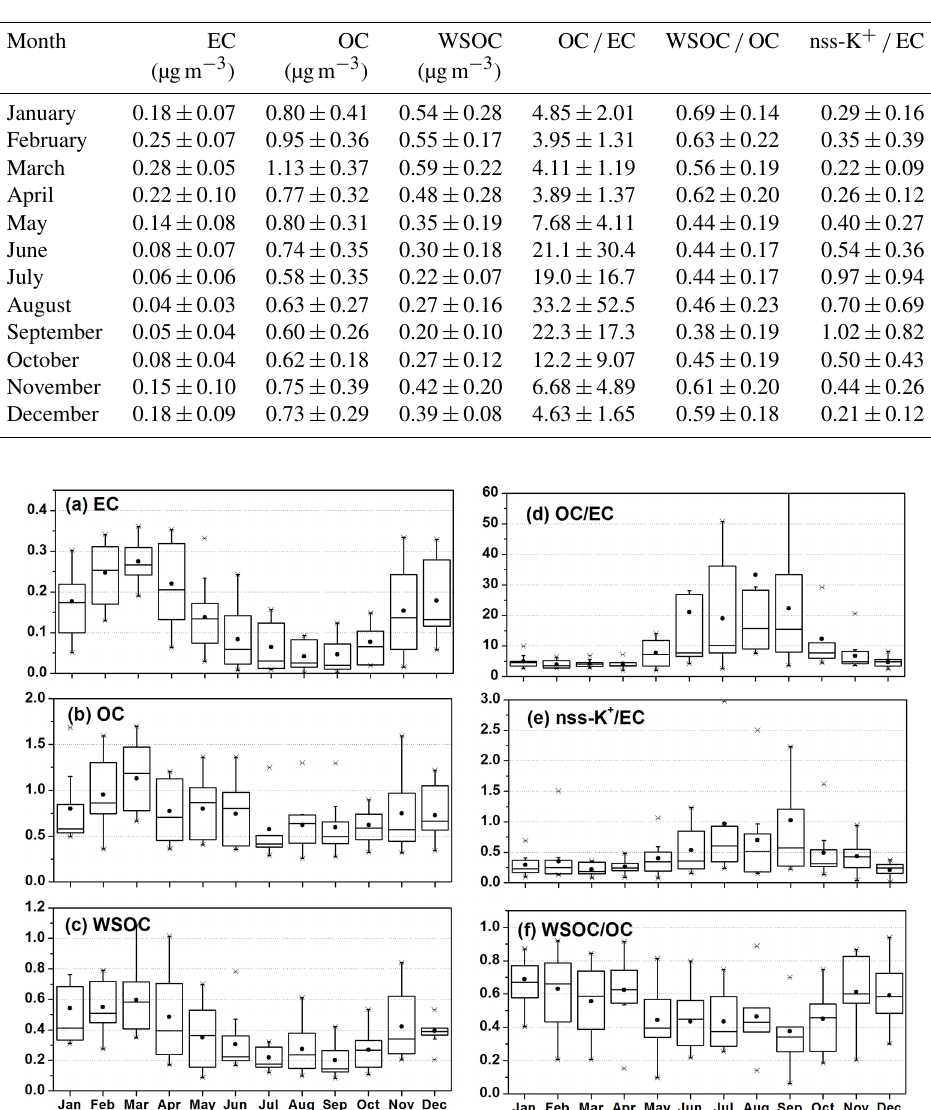
Figure 3. Box-and-whisker plots of monthly variations of carbonaceous aerosol components (µgm − 3 ) and some specific mass ratios at Chichijima in the western North Pacific during 2001–2012. The horizontal line and small dot inside the box indicate median and mean, respectively. The vertical hinges represent data points from the lower to the upper quartile (i.e., 25th and 75th percentiles). The whiskers represent data points from the 1st to 99th